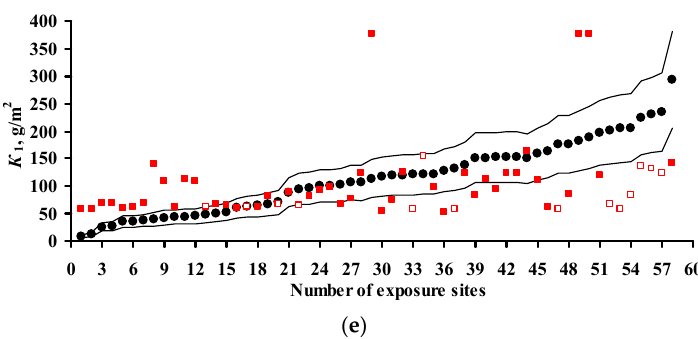
Figure 4. Carbon steel. MICAT program. K 1 predictions by the New DRF ( а ); Standard DRF ( b ); Unified DRF ( c ); linear model [20] ( d ); and linear model based on data from [20] ( e ). ● —experimental K 1 data; ■ — K 1 predictions; □ —the test locations in [20] which were not used (only for Figure 4 е ); ○ —experimental K 1 data under the assumption that they were expressed in g/m 2 rather than in μ m. Thin lines show the calculation error (±30%). The numbers of the exposure sites are given in accordance with Table 3.